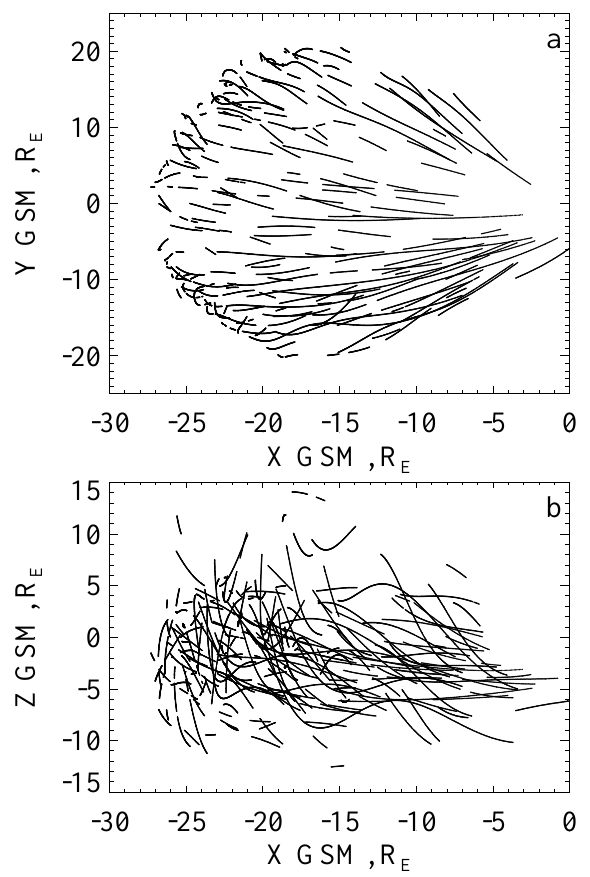
Fig. 2. Comparison of PDFs: (a) V y for Y > 0 and V y for Y < 0; (b) V z and V y for Y <